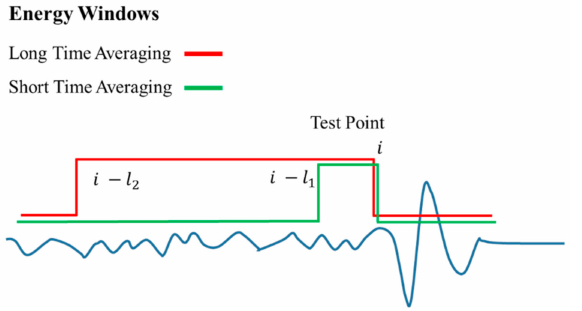
Figure 3. The conceptual representation of short-time averaging (STA) and long-time averaging (LTA) triggering method (modified from